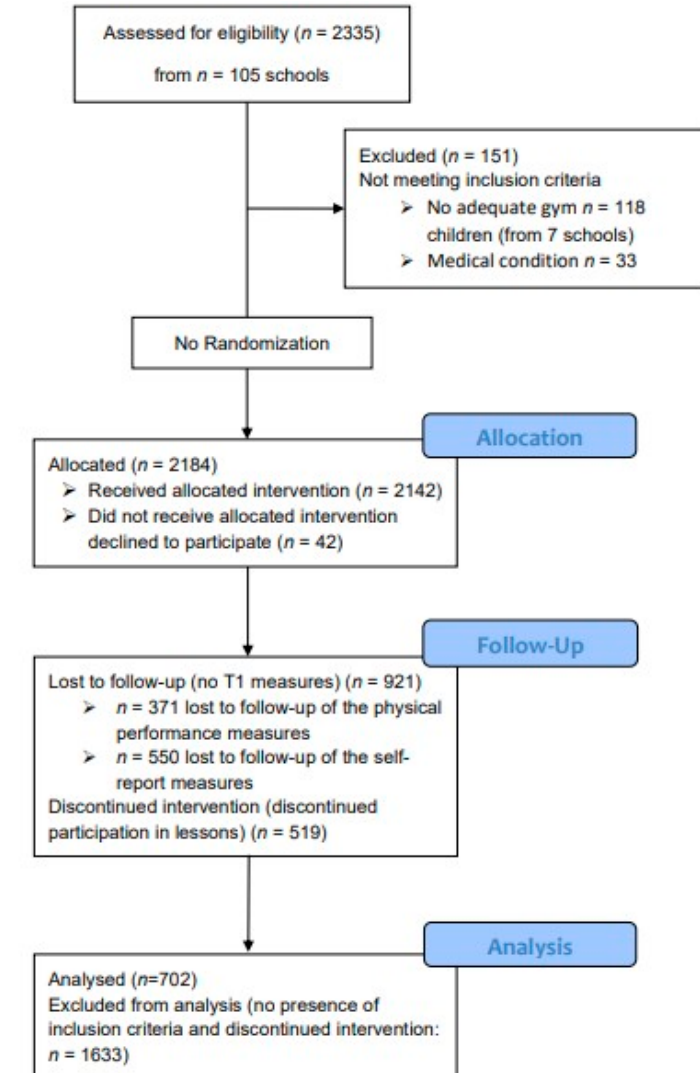
Figure 1. CONSORT Flow Diagram (adapted from CONSORT 2010 Flow Diagram).